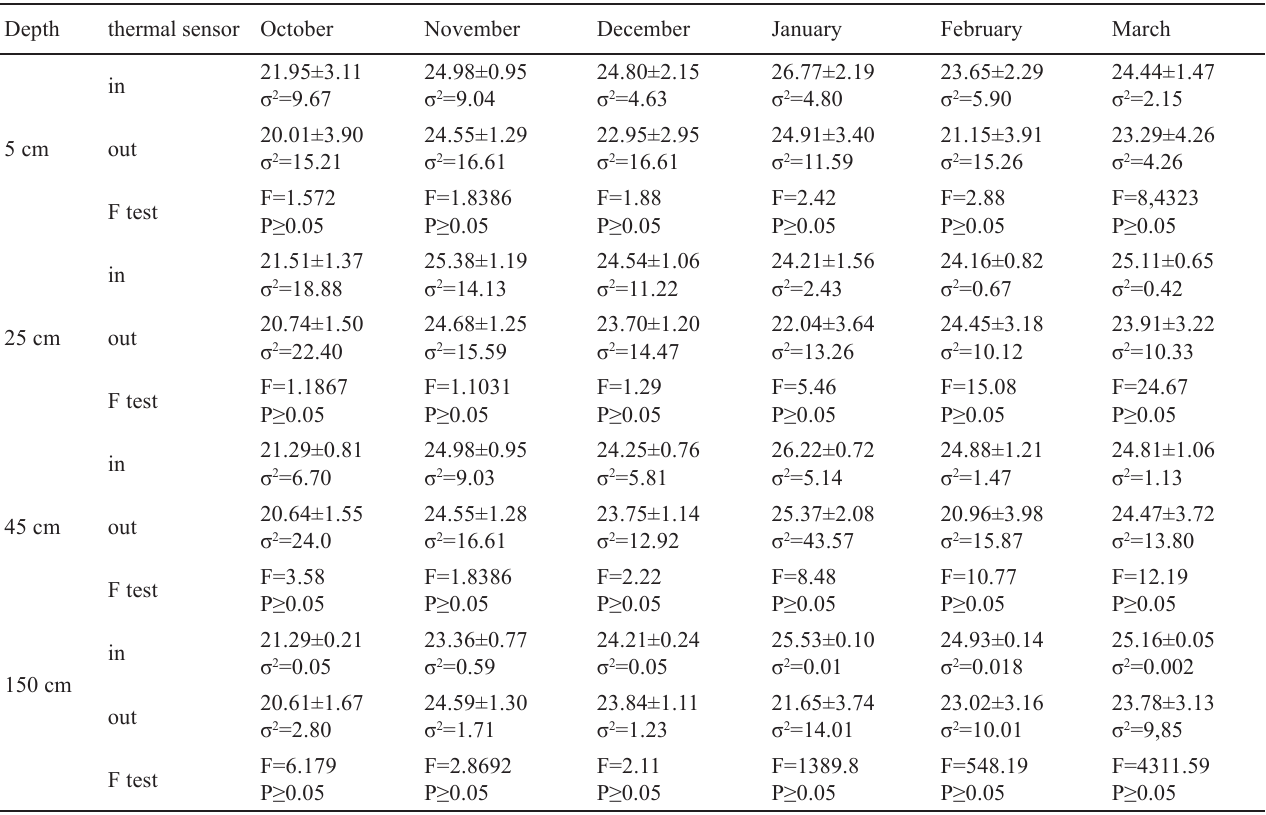
Table 1 . Summary statistics for soil temperature (mean ±sd) during 6 months.